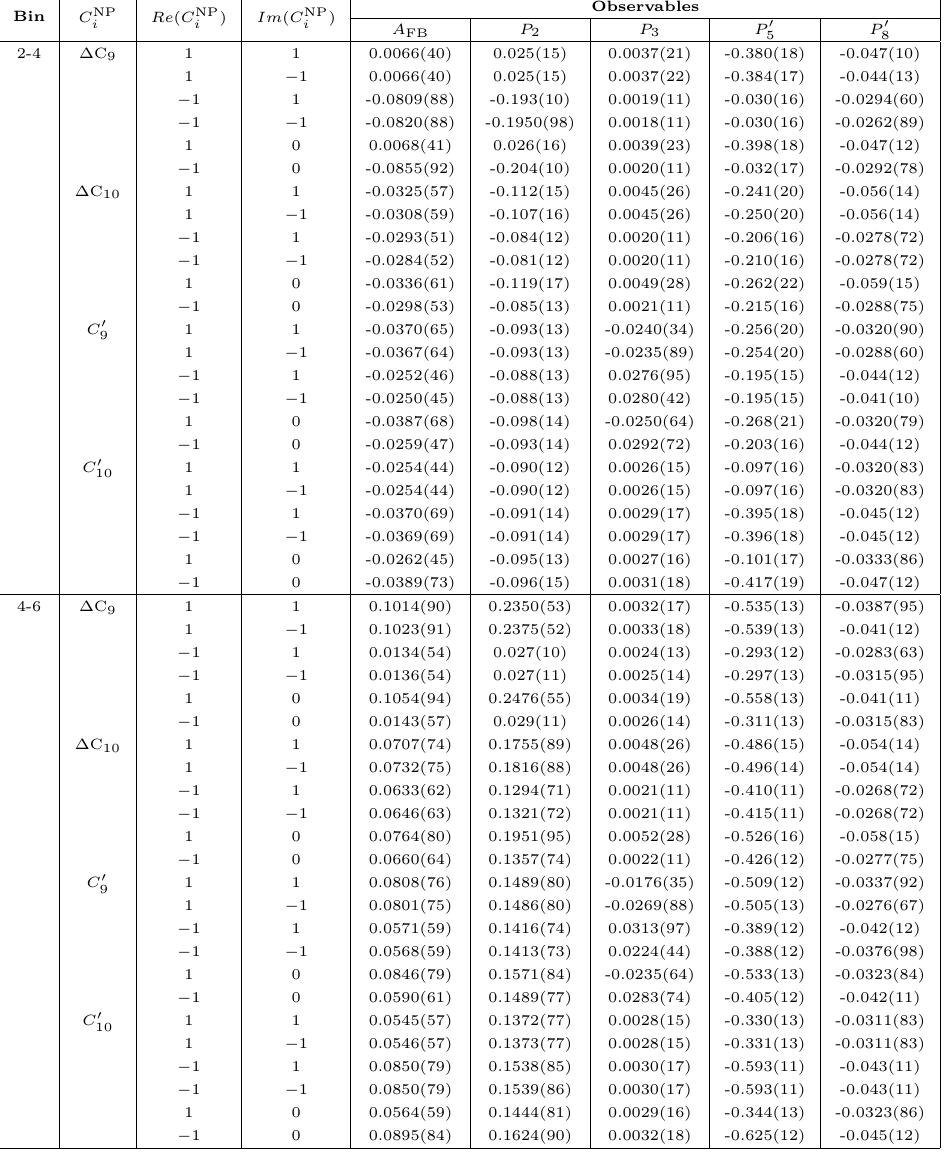
¯ B 0 ( B 0 ) → ρ 0 ll which and C 0 9 , 10 9 , 10